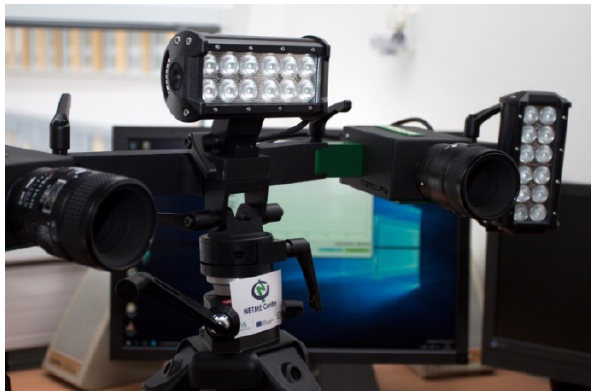
Fig. 5. Mercury RT optical device for measuring